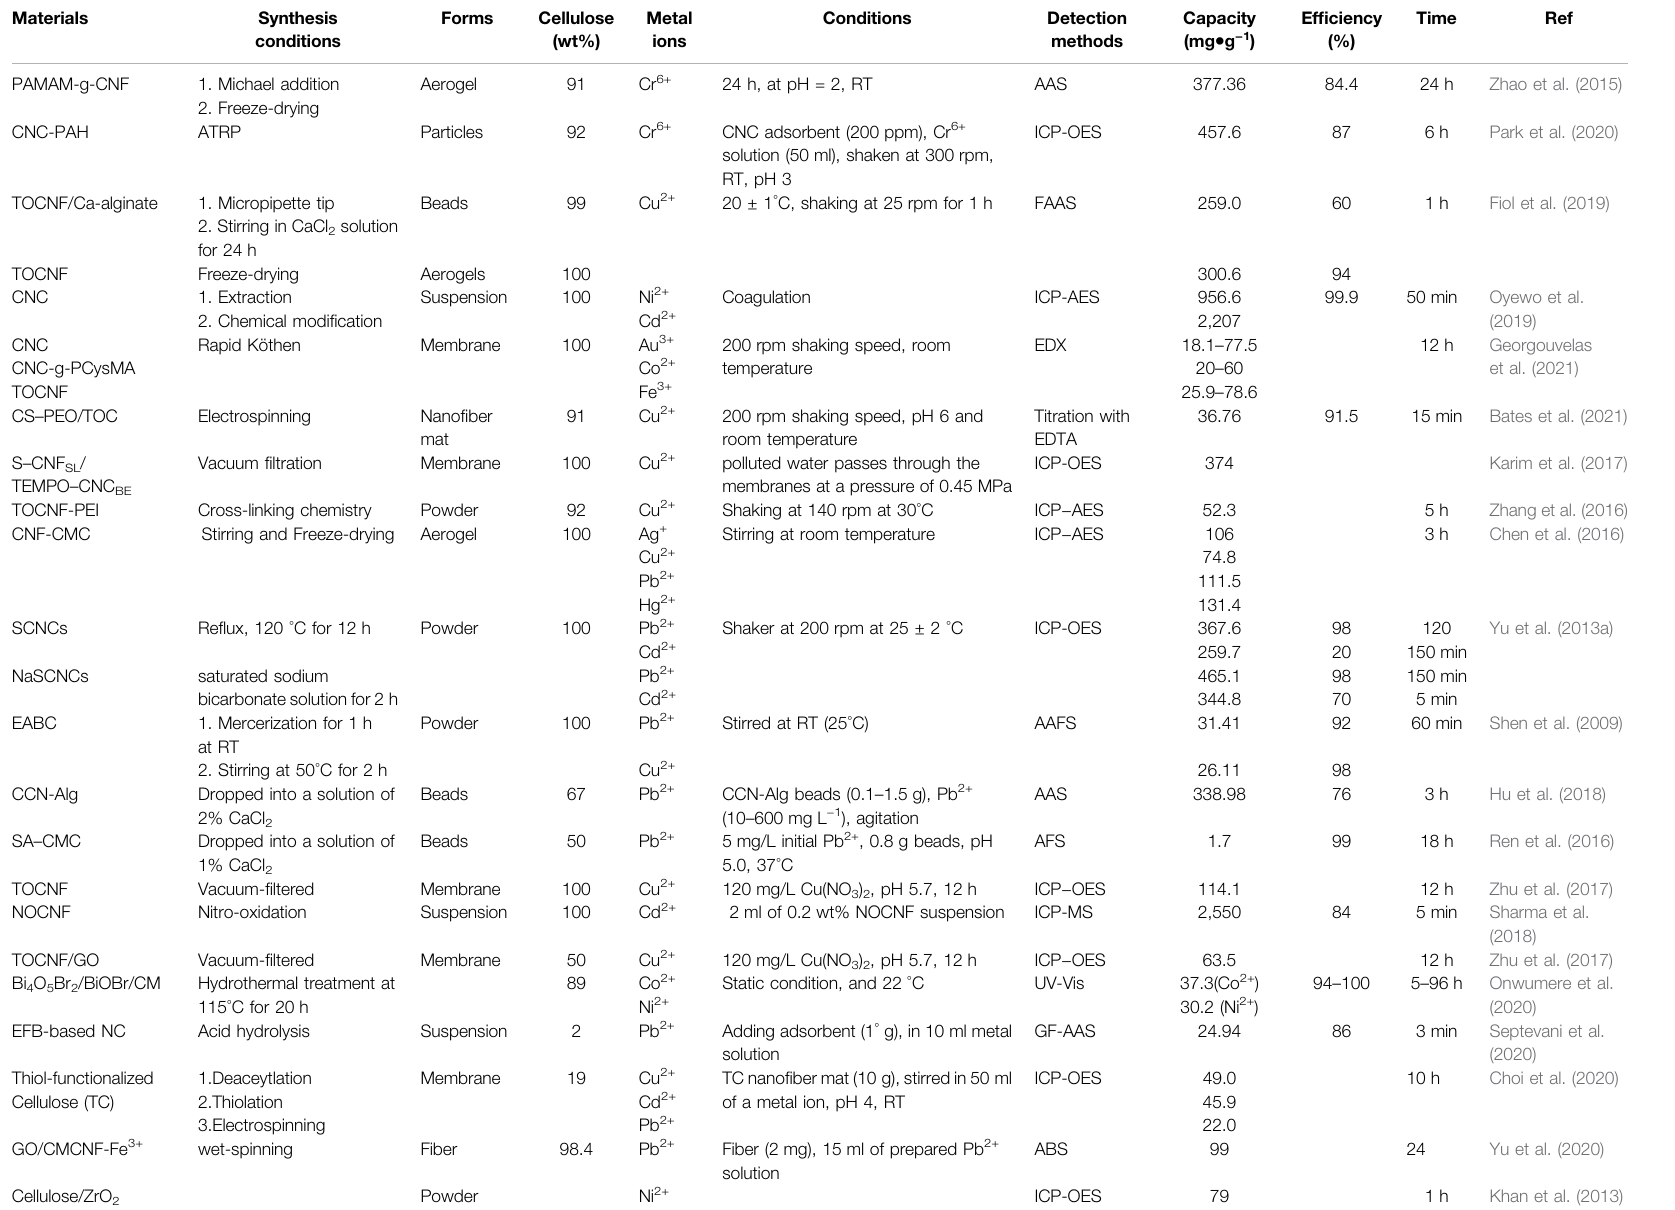
TABLE 2 | Adsorption of metal ions using Cellulose-based